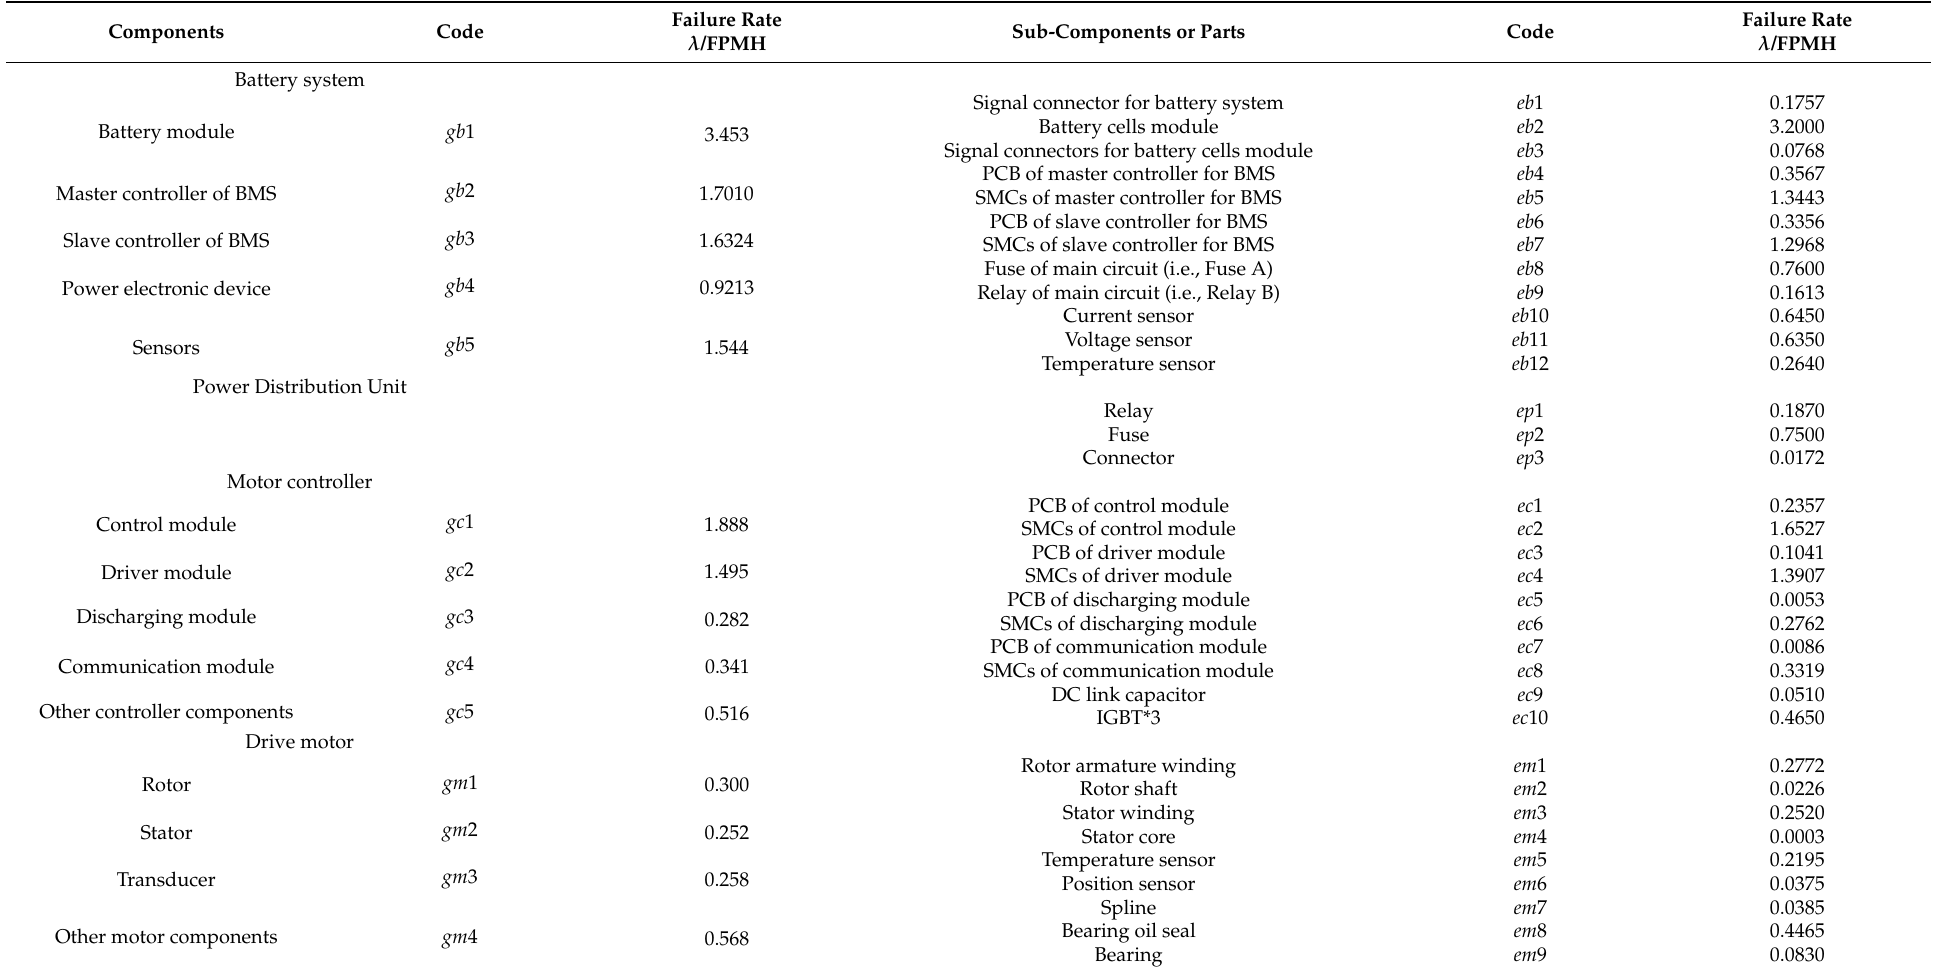
Table 3. Failure rates of subsystem components in